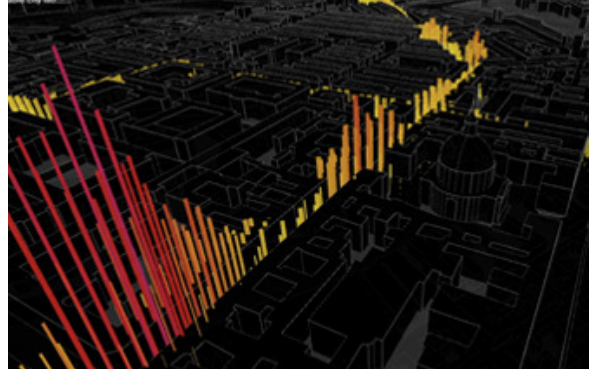
Figure 2. Environmental information displayed as bars in virtual 3D Copenhagen (Copenhagen Wheel project, Ratti et